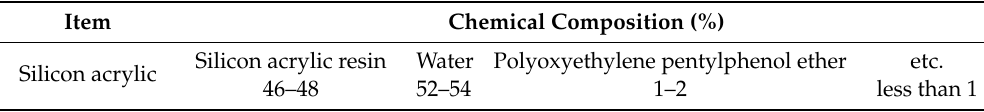
Table 2. Chemical composition of silicon acrylic surface